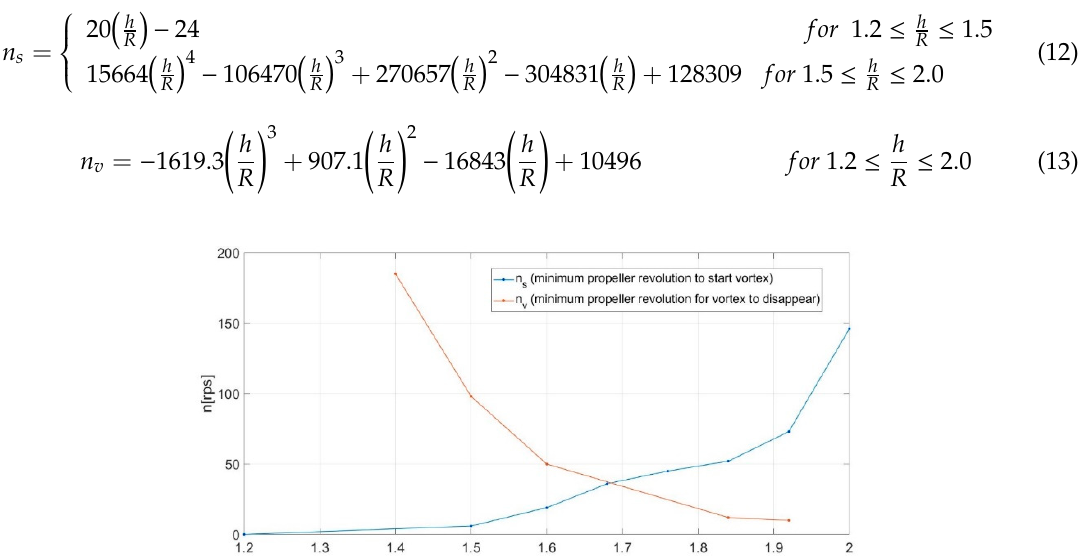
Figure 6. Minimum number of propeller revolution to establish a ventilating vortex ( n s ) and minimum number of propeller revolution for the vortex to disappear ( n v ) as a function of propeller submergence, valid only for high Weber number and low advance numbers 0.08 < J < 0.15.